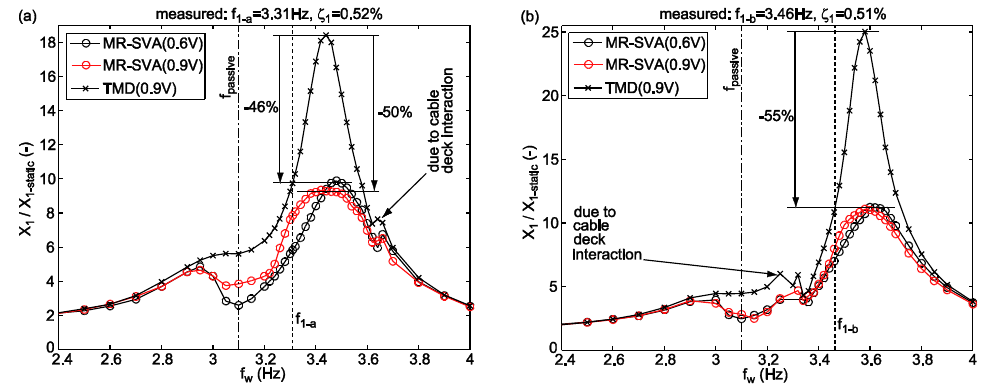
Figure 16. Measured vibration reductions of lighter bridges with ( a ) a1 f and ( b ) b1 f .